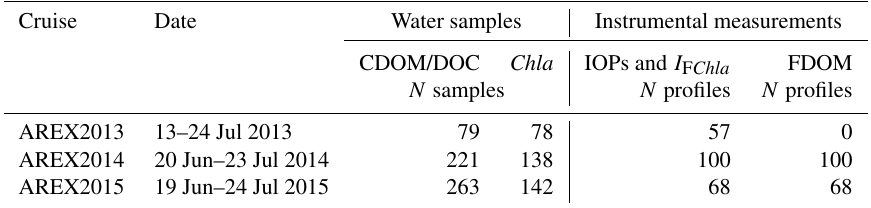
Table 1. Dates of AREX expeditions, and number of samples or number of in situ vertical profiles of CDOM, DOC, chlorophyll a ( Chla ) inherent optical properties (IOPs), chlorophyll a fluorescence ( I F Chla ), and FDOM fluorescence. Cruise Water samples Instrumental